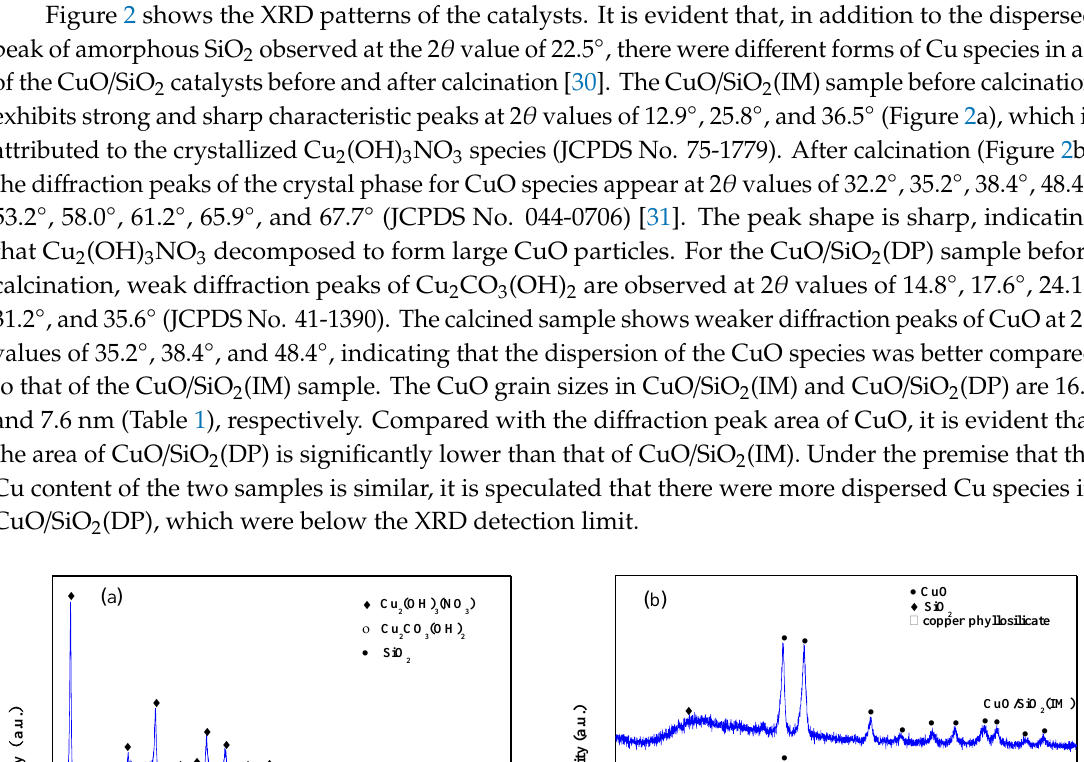
2 catalysts ( a ) before and ( b ) after